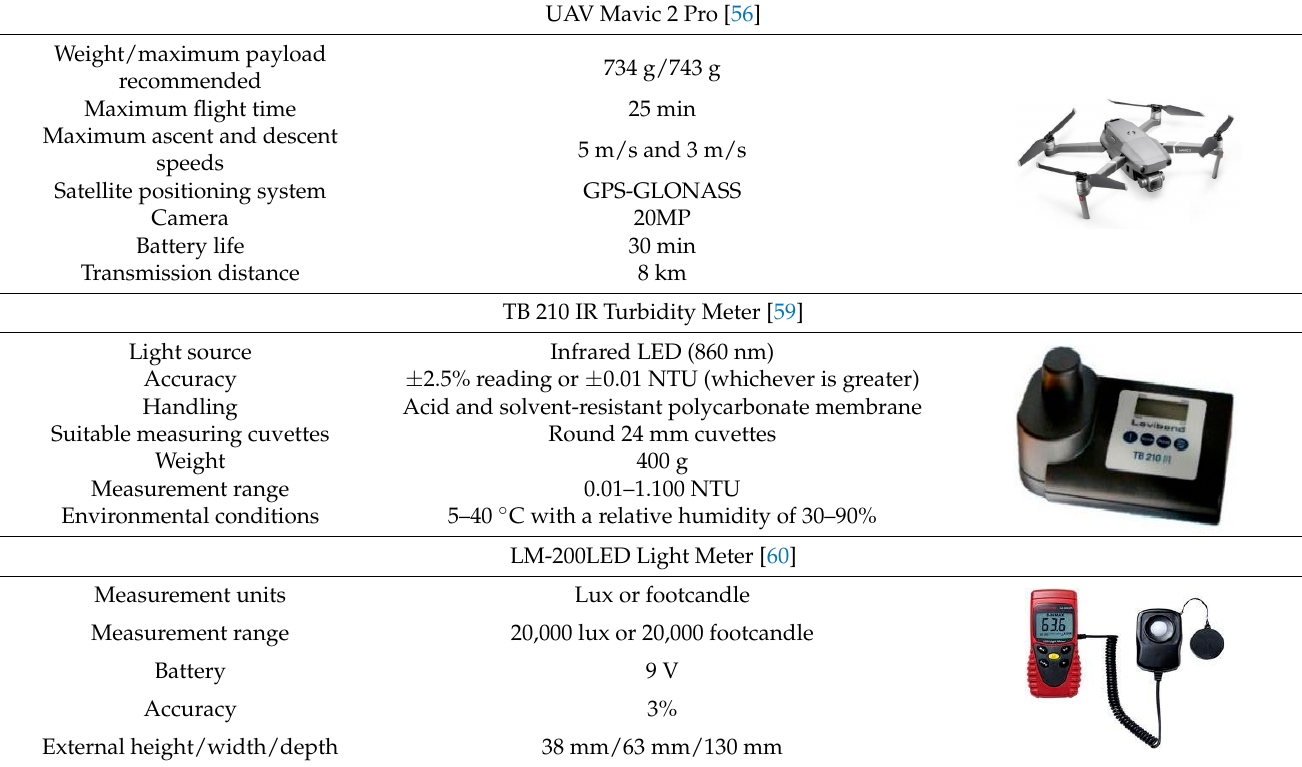
Table 2. Specifications of the equipment used in this study.